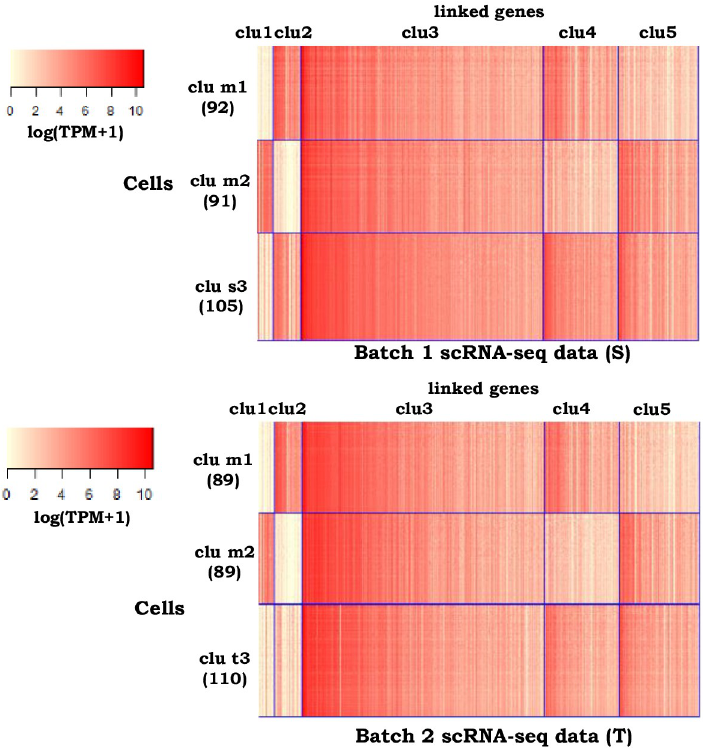
Fig 5. Heatmaps of the clustering results by couple CoC+ for example 4. “clu m” represents the matched cell cluster across the source data and the target data. “clu s” and “clu t” represent the cell clusters that are unique to the source data and the target data, respectively. For better visualization, we randomly averaged every 15 cells within the same cell cluster to generate pseudocells for every heatmap.